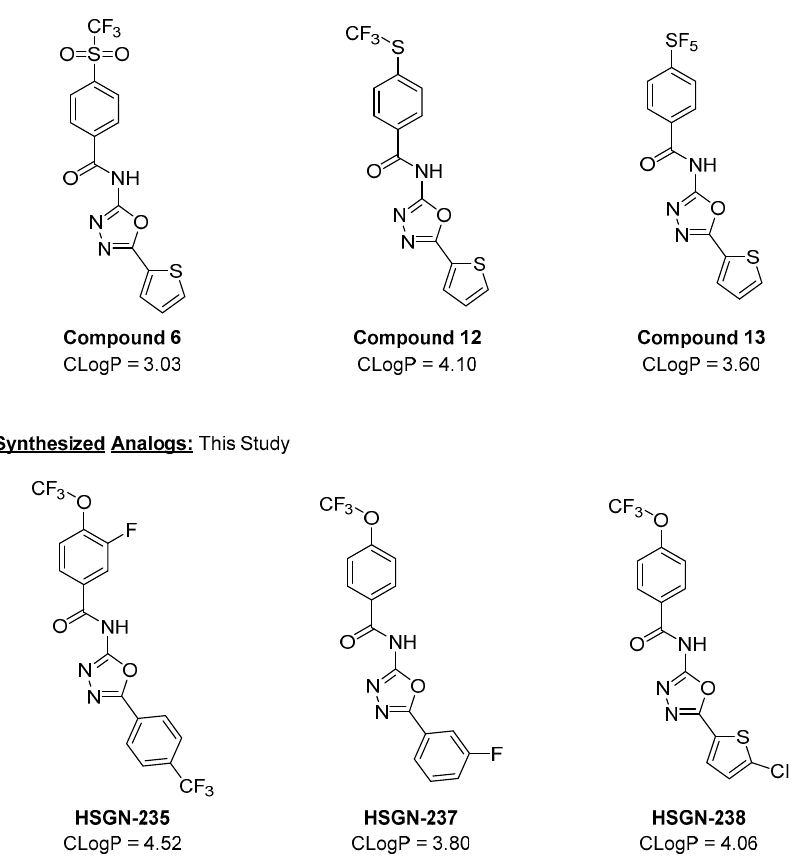
Figure 1. Previously reported analogs as well as newly synthesized N-(1,3,4-oxiadizol-2-yl)benzamides for this study. Note: CLogP was calculated using SwissADME. The synthesis of these compounds started with a substituted aryl aldehyde, fol- lowed by the addition of semicarbazide and sodium acetate to give the corresponding semicarbazone. Then, using bromine and sodium acetate, the semicarbazone was con- verted into the subsequent aryl 1,3,4-oxadizol-2-amine. Amide coupling between the aryl 1,3,4-oxadiazol-2-amine and 4-trifluoromethoxy benzoic acid using benzotriazol-1- yloxytris(dimethylamino)phosphonium hexafluorophosphate (BOP) reagent gave the desired N-(1,3,4-oxadiazol-2-yl)benzamides (Scheme 1).